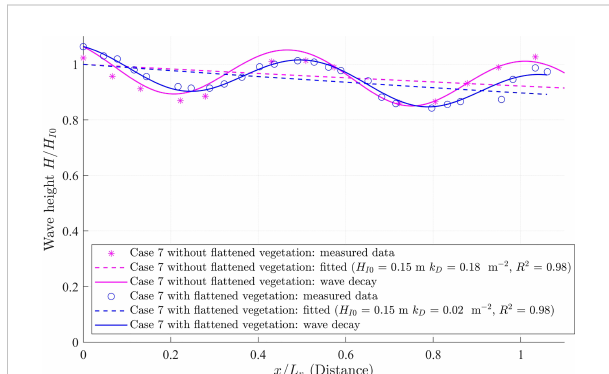
FIGURE A1 Measured (magenta asterisks for that without vegetation and blue circles for that with vegetation) and fi tted (solid lines) wave heights ( H ) normalized by the incident wave height ( H I 0 ) along the vegetation regions for Case 7. The calculated incident wave height decay with fi tted H I 0 and k D is denoted by dashed lines. The magenta lines are for the case without vegetation while the blue lines are for the case with vegetation. The horizontal distance is normalized by the canopy length as x / L v